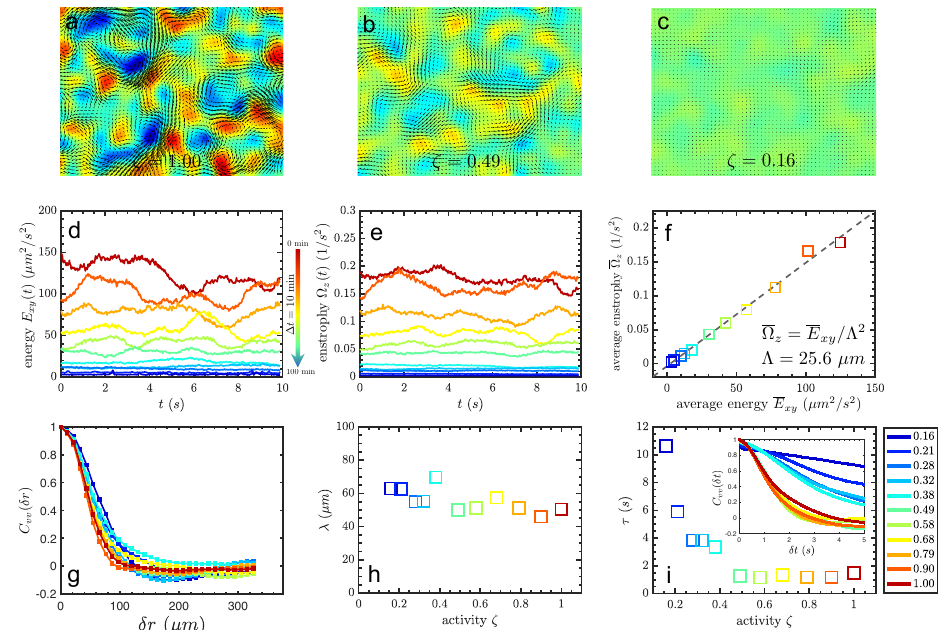
Figure 2. ( a – c ): Velocity filed of the bacterial turbulence via PIV analysis. ( d , e ): Total kinetic energy and enstrophy of the flow field with decaying activities at each waiting period of 10 min within a total time of 100 min, indicated by the color plots (i.e., red for highest activity, and blue for lowest activity). ( f ): Linear relation between kinetic energy and enstrophy with a slope of Λ 2 , corresponding to the square of the typical radius of the vortices. ( g ): Correlation length from velocity field, and its dependence on activity in ( h ). ( i ): Correlation time (inset) vs.